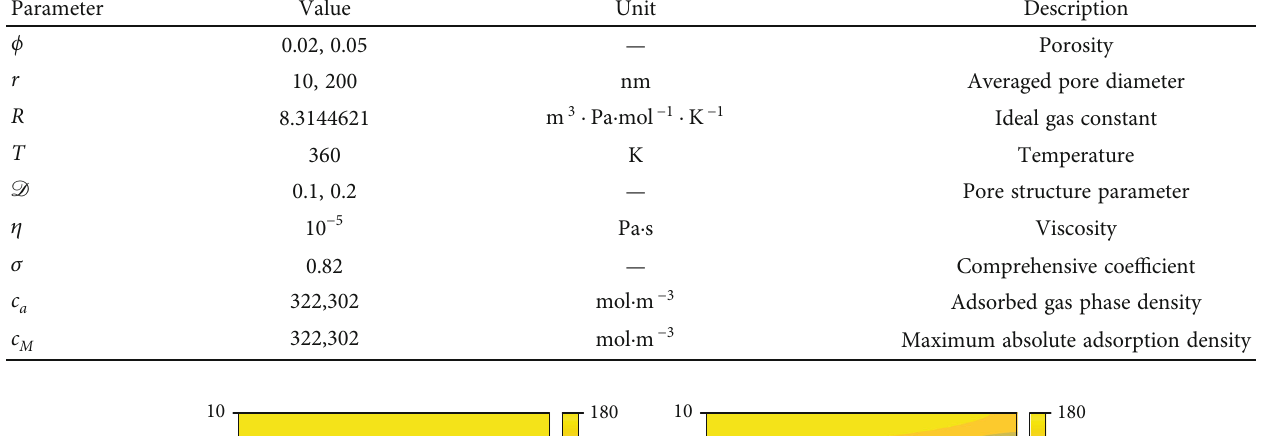
Table 3: Parameters of the model used in example 2.